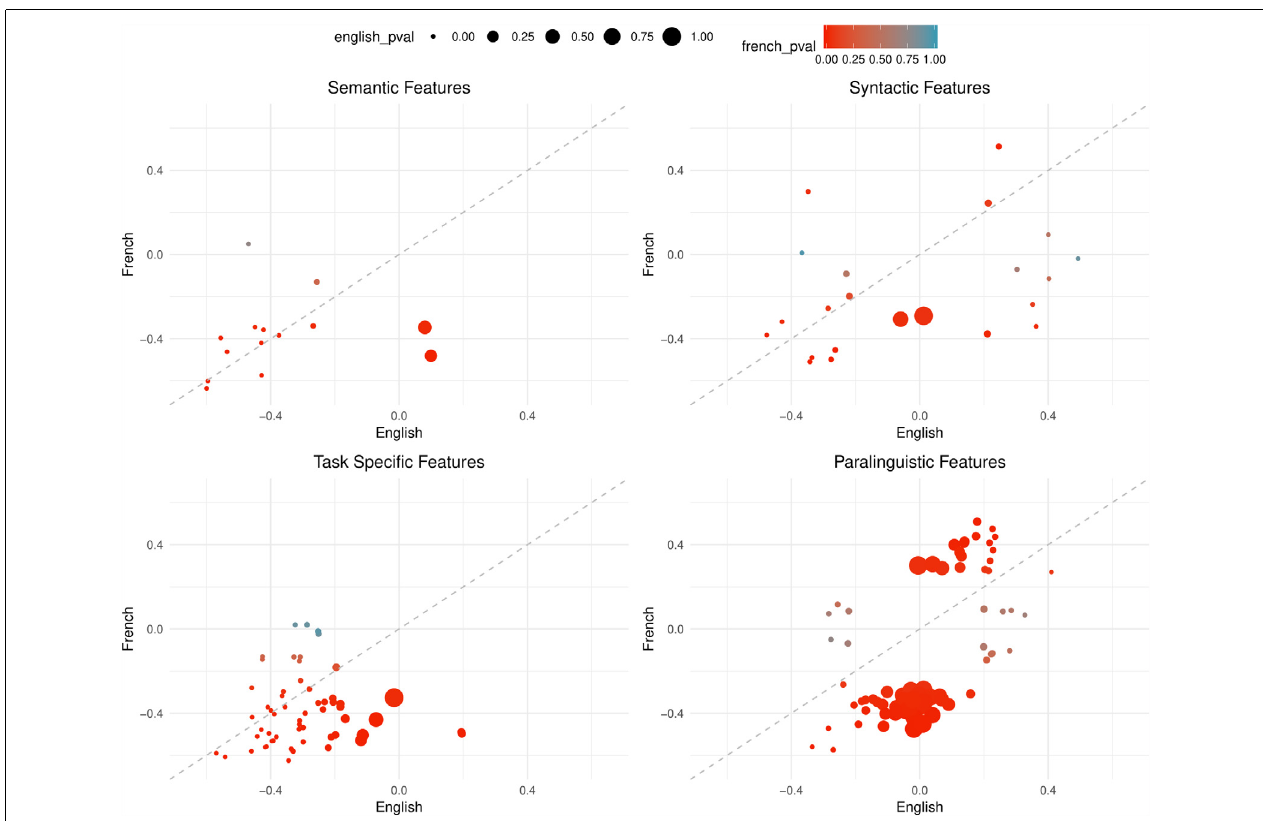
FIGURE 2 | Points are plotted by correlation values (point-biserial correlation coefficient r PB , correlating the feature with the group AD vs. HC) with French on the Y-axis and English on the X-axis for each feature subgroup. The significance value (as by Kruskal–Wallis non-corrected significance test p < 0.05) is visualized by point color for French and point size for English. Points closer to the dashed line perform equally well in both languages. This figure contains all features that are significant in EITHER French or English, not necessarily